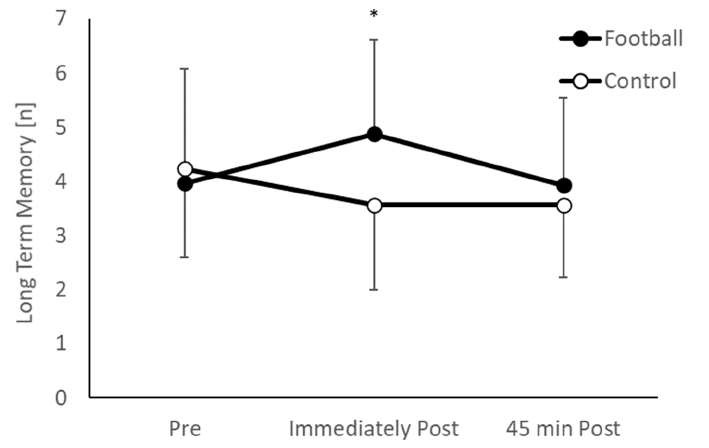
Figure 3. Long term memory performance ([n] = number of correctly recalled words) in the football and control groups across the morning (group * time interaction, p < 0.001; * football > control, p < 0.001).